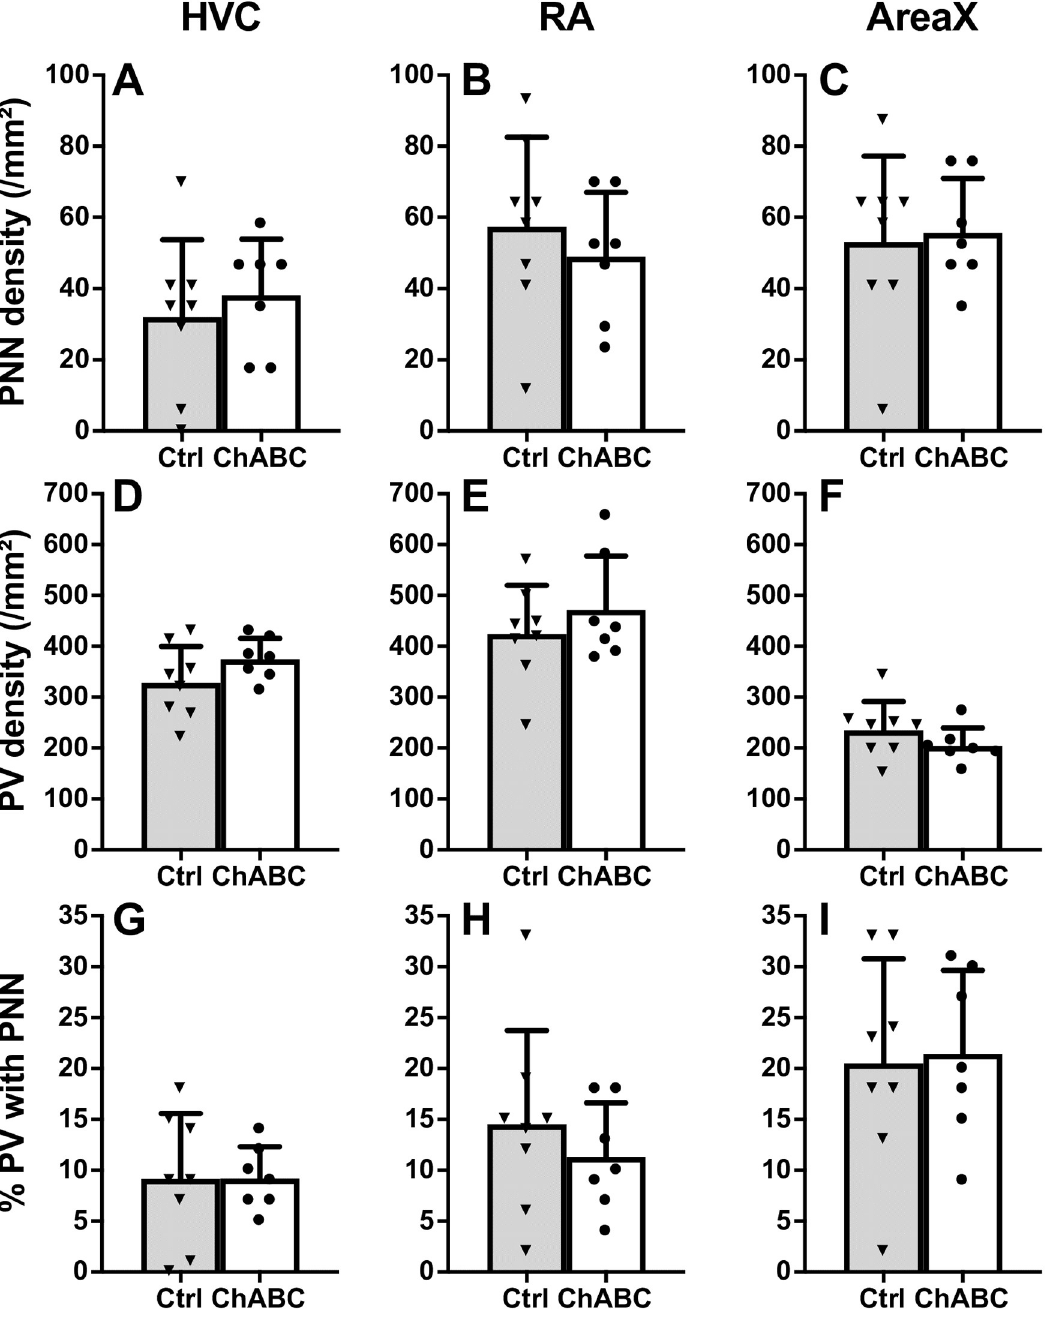
Fig 10. Effects of chondroitinase ABC (ChABC) on PNN in the song control nuclei of male canaries as measured in experiment 2. Density of PNN (A-C), density of PV positive cells (D-F), and % PV with PNN (G-I) in HVC, RA and Area X of Ctrl (grey bars) and bilaterally ChABC-treated (open bars) birds. Brains were collected four months after the treatments. Individual values are indicated by dots or triangles. T-test were used to compare groups but no significant differences were detected.